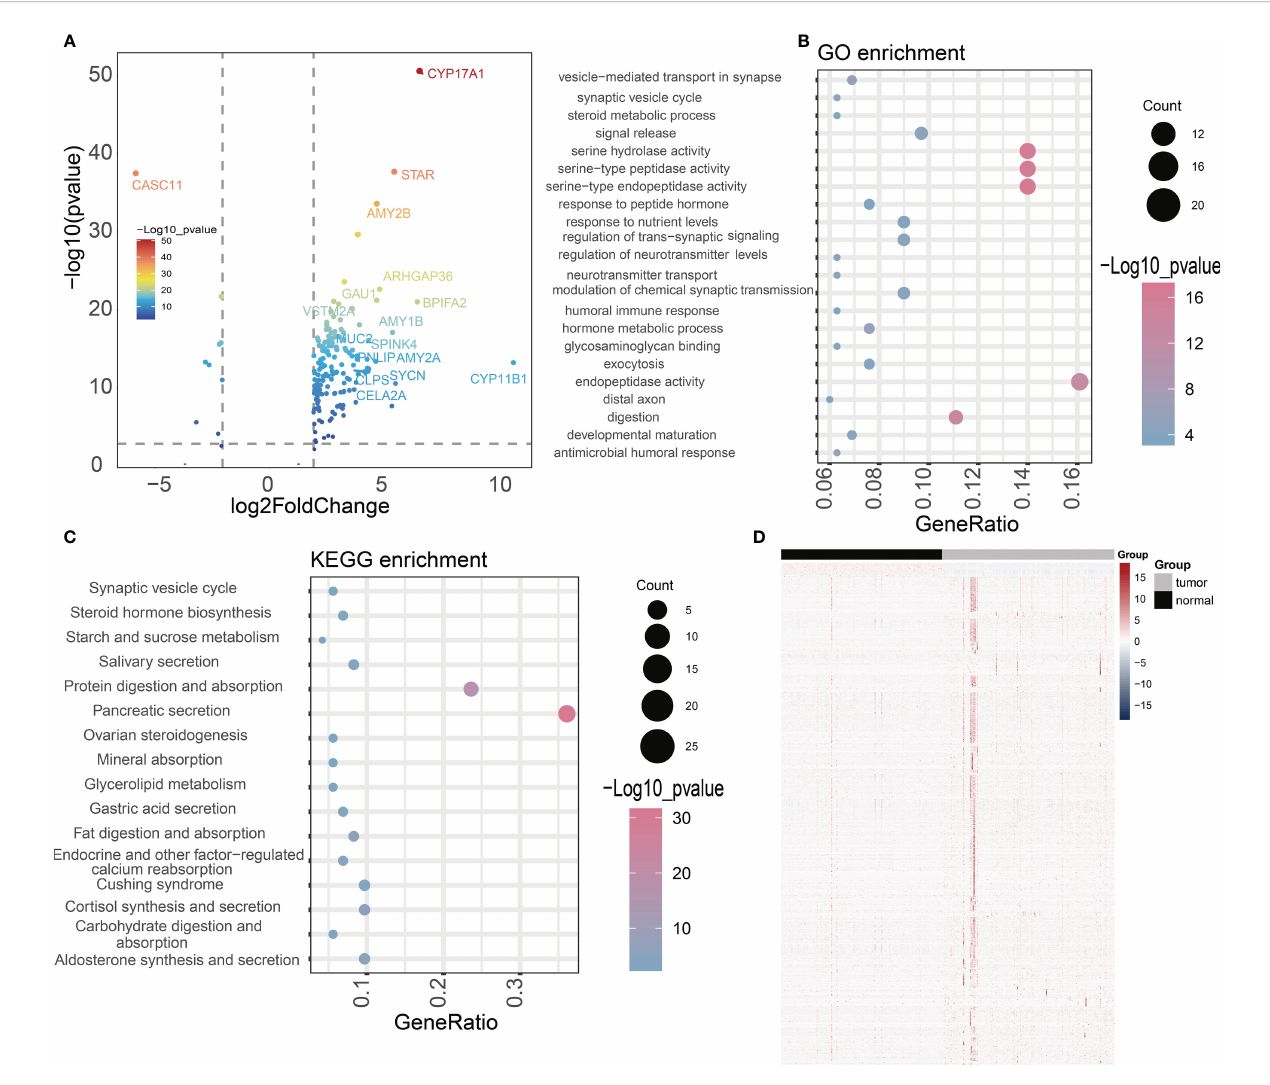
FIGURE 4 Difference analysis and enrichment analysis. (A) The volcano map shows NOX4-related differential expression genes. (B, C) GO and KEGG analyses for NOX4-related differentially expressed genes. (D) Heatmap of the lncRNAs highly correlated with NOX4 in pancreatic tumors and normal